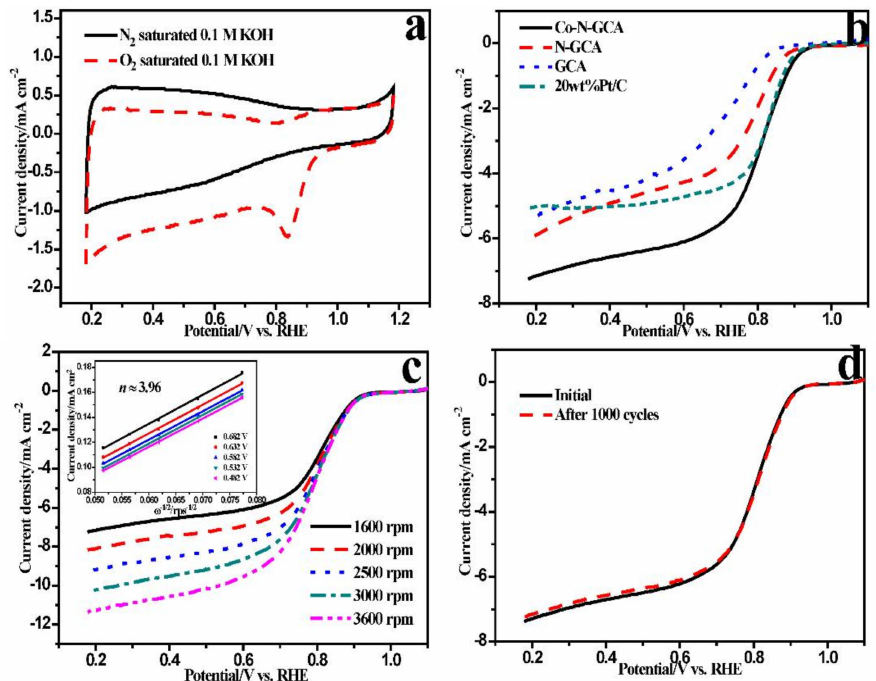
Figure 5. ( a ) Cyclic voltammetry (CV) curves of Co-N-GCA in N 2 - and O 2 -saturated 0.1 M KOH solutions; ( b ) linear sweep voltammetry (LSV) curves of Co-N-GCA, N-GCA, GCA, and commercial 20 wt. % Pt/C at a rotation speed of 1600 rpm; ( c ) LSV curves of Co-N-GCA at 1600–3600 rpm rotation speeds (inset shows the corresponding K–L plots); ( d ) LSV plots of Co-N-GCA at a rotation speed of 1600 rpm before and after 1000 CV (50 mV s − 1 )